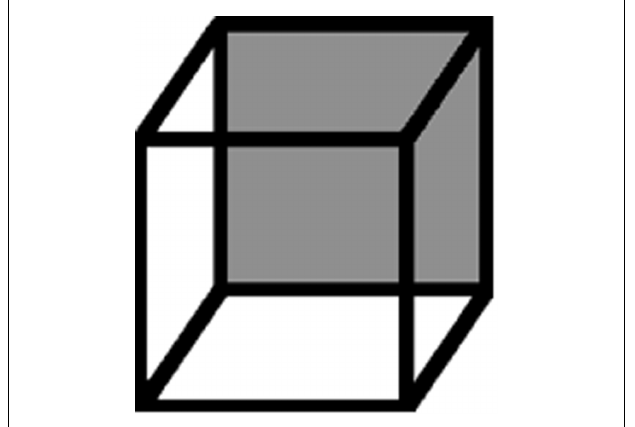
FIGURE 3 |The Necker